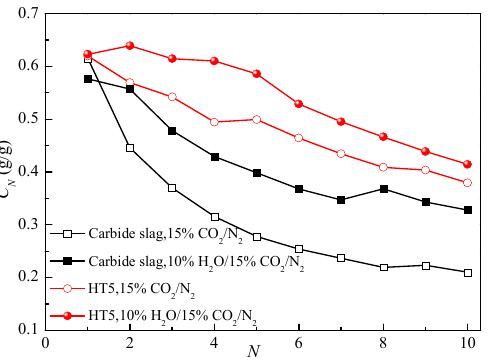
Figure 7. Effects of H 2 O existing in the carbonation atmosphere on the CO 2 capture capacities of HT5 (carbonation at 700 °C for 20 min, calcination in 70% CO 2 /N 2 at 920 °C for 10 min).